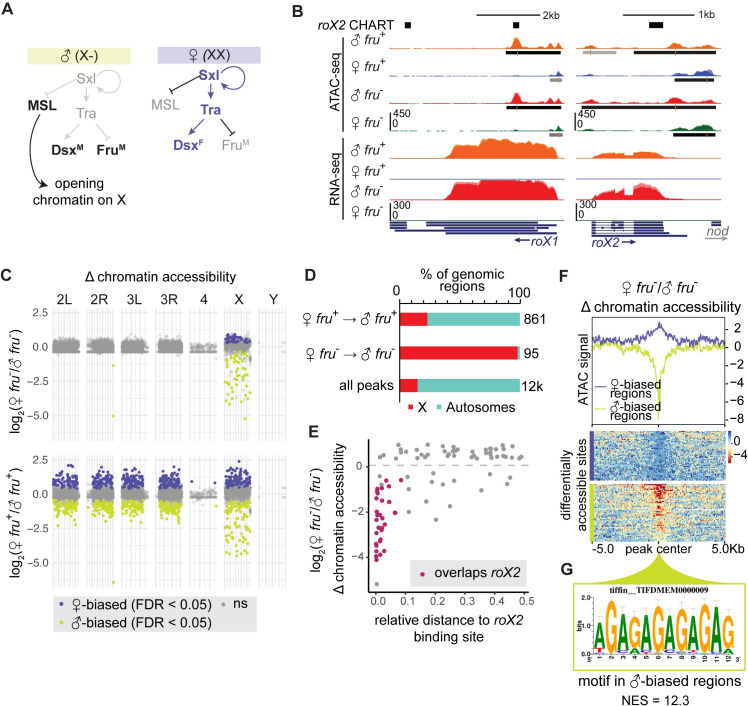
Sexually dimorphic, FruM-independent peaks reflect dosage compensation.A. Schematic of dosage compensation in D. mel. B. UCSC genome browser screenshot of ATAC-seq and RNA-seq signal at canonical dosage compensation genes lncRNA:roX1 and lncRNA:roX2. roX2 CHART (black bars) shows known tethering sites of lncRNA:roX2 to chromatin [39]. C. Manhattan plot of log2(female/male) chromatin accessibility in fru+ and fru- neurons across chromosomes. Points represent genomic regions. Vertical axes show the relative change in accessibility of a region from DiffBind output. Horizontal axes represent scaled chromosomal locations. Regions with no change in accessibility between samples (FDR > 0.05) are plotted in gray. Regions with male-biased accessibility (chartreuse) appear as negative fold change, and regions with female-biased accessibility (purple) appear as positive fold change. D. Summary of X versus autosome distribution of differentially accessible genomic regions (DiffBind, FDR<0.05) versus all peaks (MACS2, FDR<0.001). E. Relative distance of regions specifically accessible in female versus male fru- neurons to lncRNA:roX2 binding sites identified by CHART [39]. Sex-biased regions which directly overlap a roX2 tethering site are highlighted in magenta. F. Signal heatmap of log2 fold change (log2FC) in ATAC-seq coverage between female fru- and male fru- neurons. Line plot shows mean log2FC in signal across reference-anchored regions. Signal heatmaps below are split into regions with female-biased (purple) or male-biased (chartreuse) accessibility. G. I-cisTarget analysis of male-biased regions shows enrichment of a GAGA motif matching the known CES motif for the dosage compensation machinery. The normalized enrichment score of the motif is 12.3.